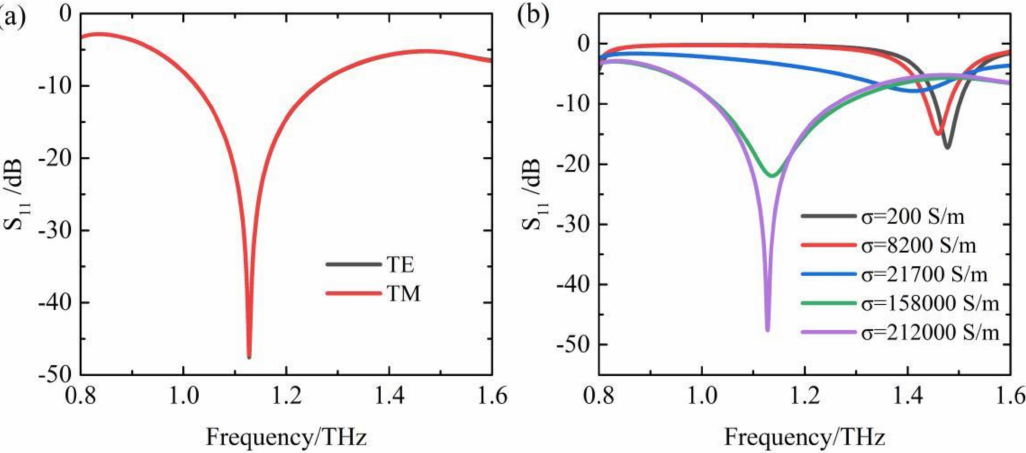
Figure 2. ( a ) Relation between the reflection coefficient and frequency of the absorber under different polarized incidence; ( b ) relation between the reflection coefficient and frequency of the absorber under different VO 2 conductivities.